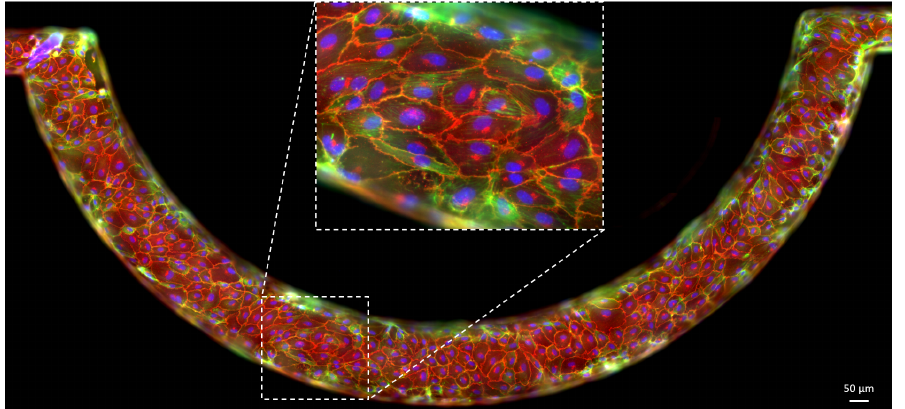
Figure 6. Fluorescence image of an endothelial monolayer lining the walls of the vascular channel. The endothelium shows full-maturation features, with VE-cadherin (red) arranged in a continuous linear pattern in the interendothelial junctions. Actin filaments (green) form stress fibres or cortical filaments interacting with junctional complexes and driving their organisation. Cell nuclei are stained with DAPI (blue). The inset highlights the characteristics of the mature endothelial barrier. The blurry regions at the vascular channel edges are due to the three-dimensional structure of the endothelium. They are the effect of the superimposition of fluorescence from layers at different depth along the lateral walls of the